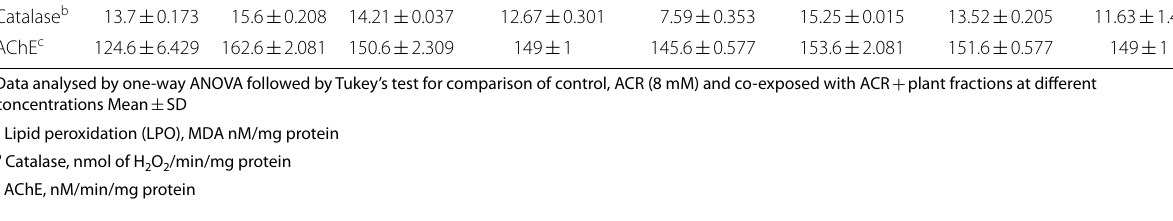
plant fractions at different +